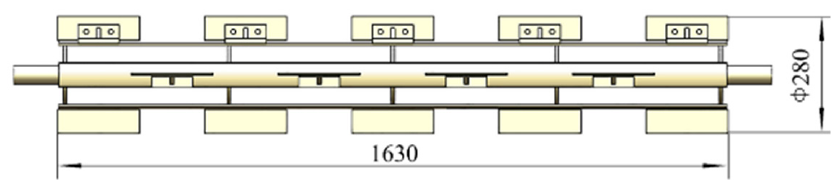
Figure 10. Layout of the soil-crushing guide roller and plank teeth.